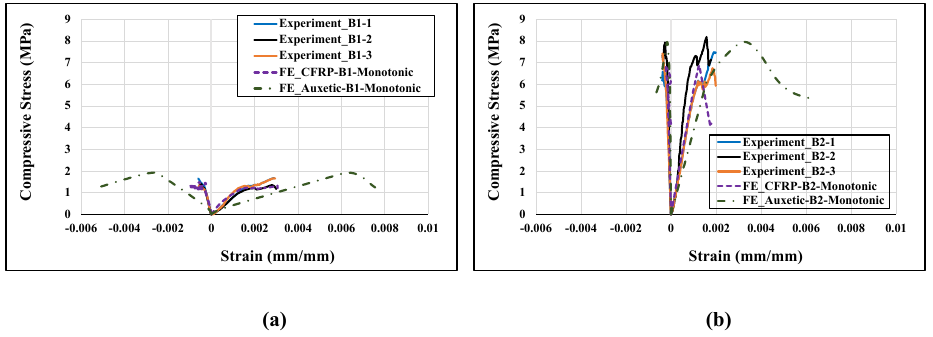
Figure 20. Stress-strain curve of CFRP-strengthened masonry wallettes construct of different types of